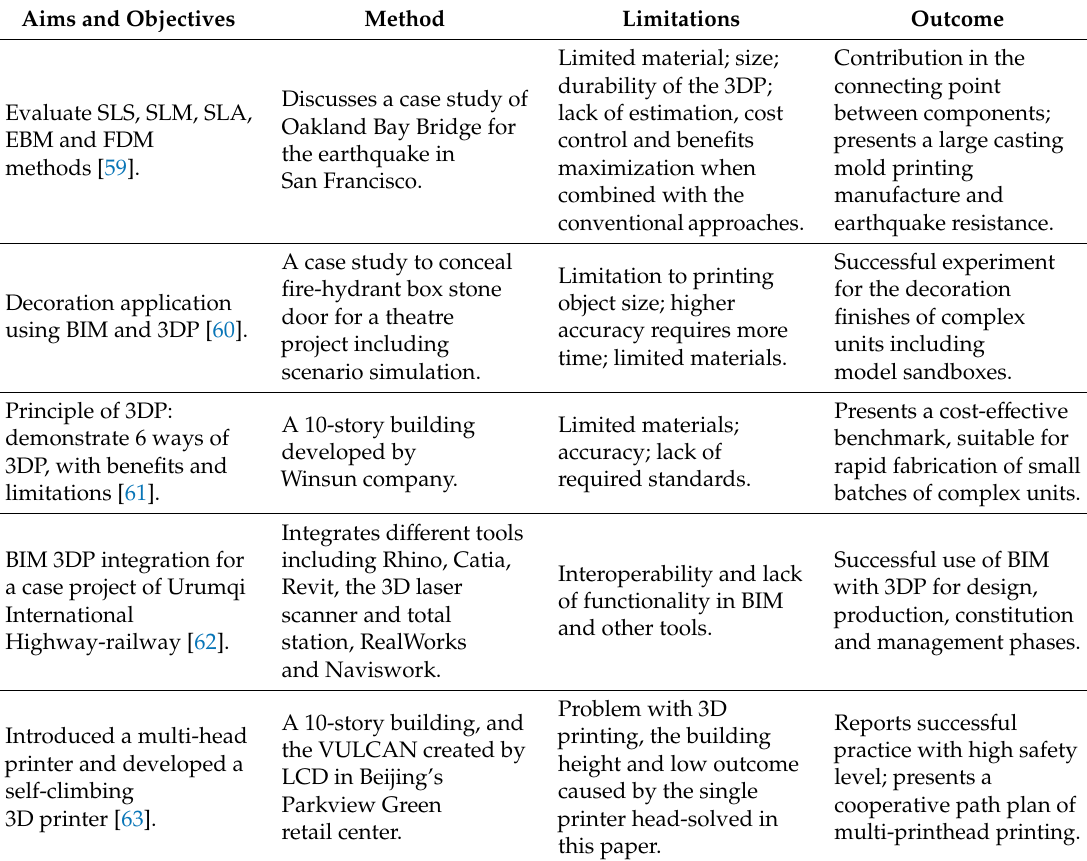
Table 3. Selected papers from the CNKI database related to general concepts of 3DP